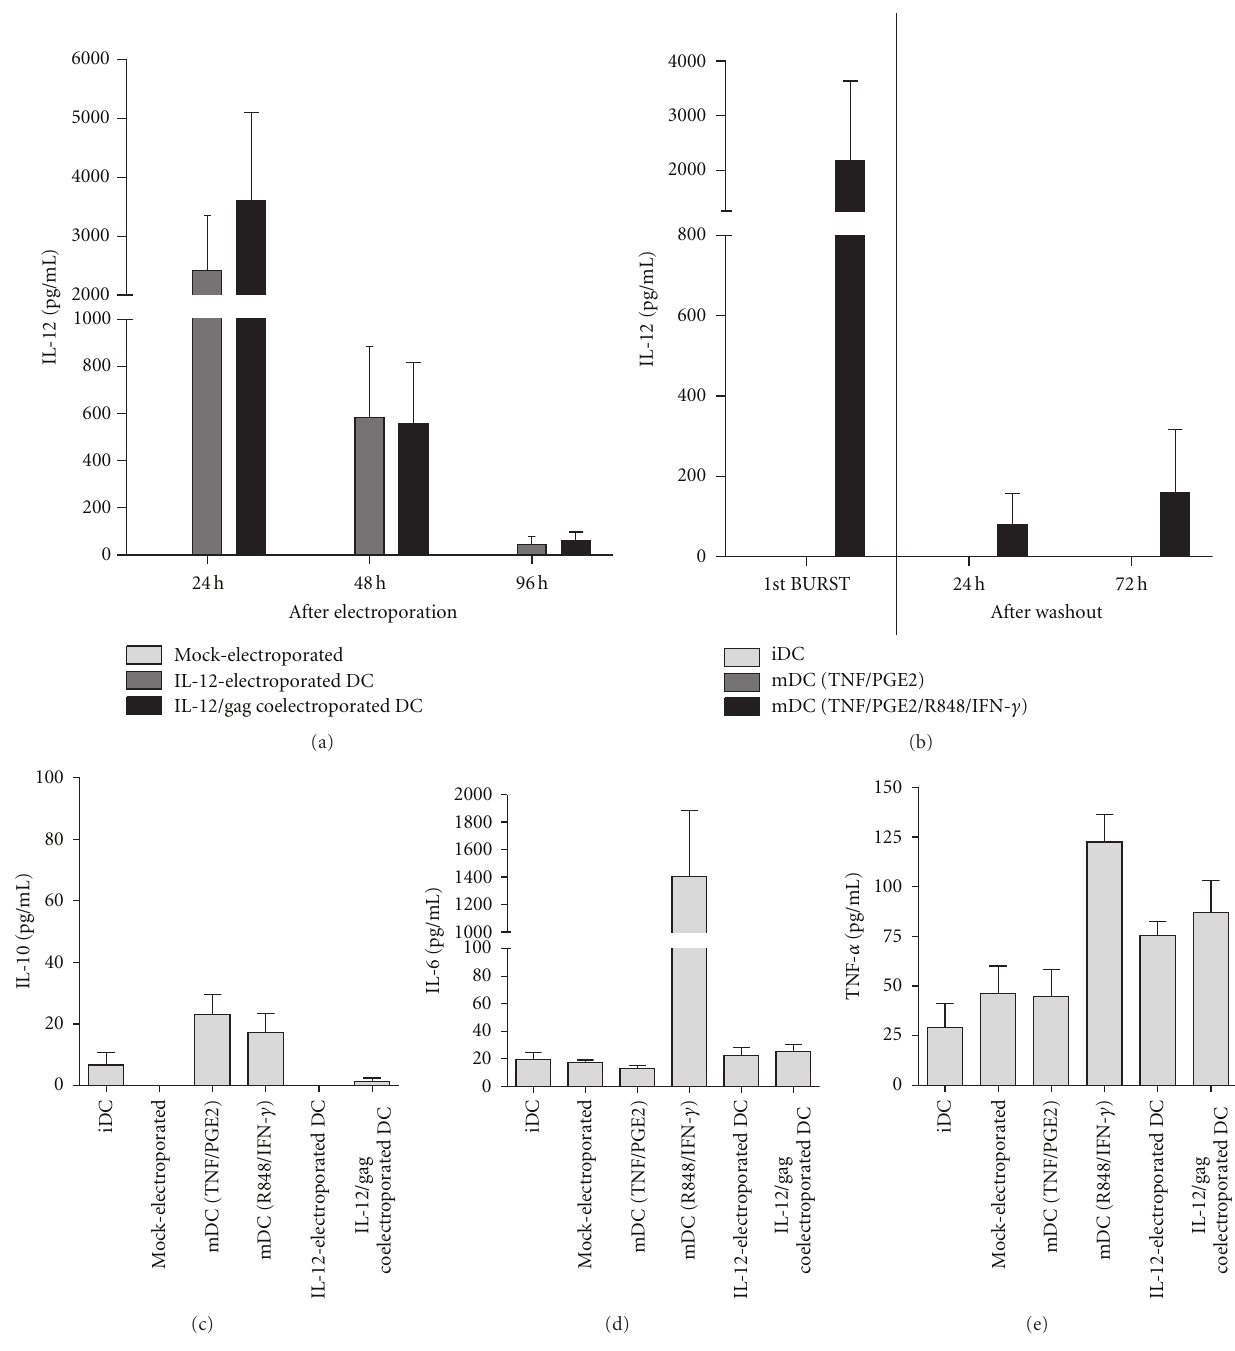
Figure 1: Production of pro- and anti-inflammatory cytokines by DCs modulated to express IL-12p70. (a) IL-12 secretion by DCs electroporated with IL-12p70-encoding mRNA. DCs were examined after incubation with a proinflammatory cytokine cocktail consisting of TNF- α and PGE 2 and electroporated with mRNA encoding IL-12p70 or with IL-12p70-encoding mRNA in combination with hHxB-2 gag - encoding mRNA. As a control mock-electroporated mature DCs were examined. DC culture supernatant was collected 24 h, 48 h, and 96 h after electroporation. Results are shown as mean ± standard deviation ( n = 5). (b) IL-12 secretion by immune-modulated DCs. DCs were examined after incubation with a proinflammatory cytokine cocktail consisting of TNF- α and PGE 2 or activated under the same conditions supplemented with R848 and IFN- γ . As a control untreated, that is, immature DCs (iDCs) were examined. DC culture supernatant was collected 24 h after activation with proinflammatory stimuli, as well as 24h and 72h after a washout experiment. Results are shown as mean ± standard deviation ( n = 5). (c), (d), and (e) Cytokine secretion by DCs activated under di ff erent experimental conditions and after a 24 h washout period. Values are shown for (c) IL-10, (d) IL-6, and (e) TNF- α . Results are shown as mean ± SD ( n =